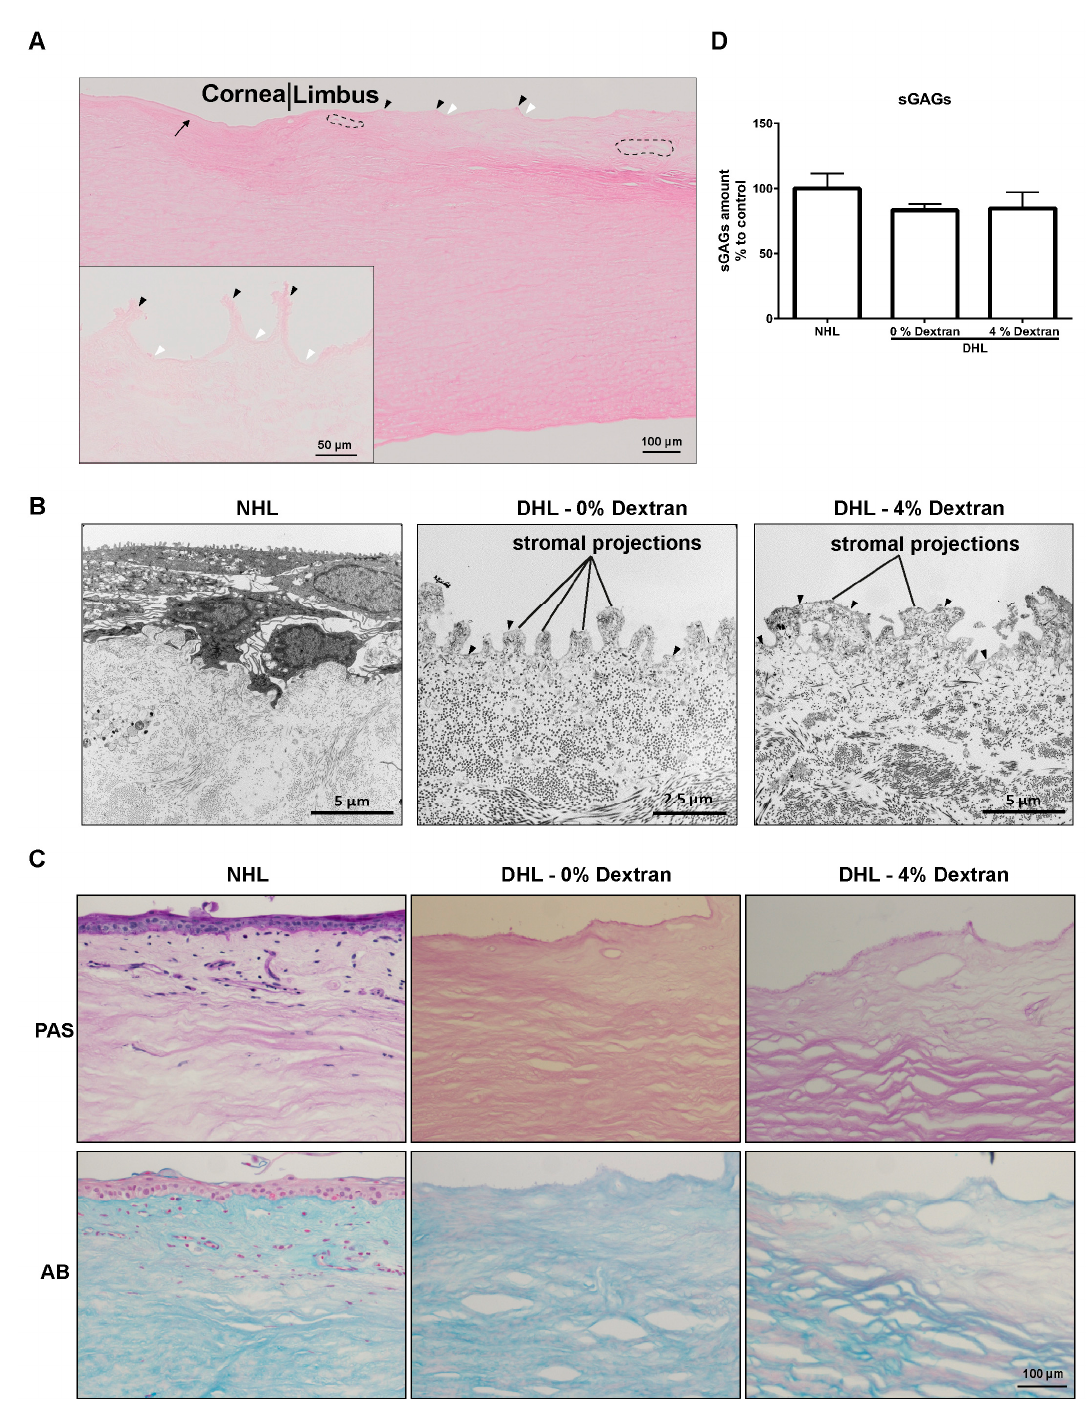
Figure 2. Structural and biochemical composition of the decellularized human limbus (DHL). ( A ) The hematoxylin and eosin staining of DHL scaffold showing the Bowman’s layer (arrow), connective tissue protrusions (black arrowheads), invaginations (white arrowheads), and vascular gaps (dashed circles). Insight showing the stromal projections (black arrowheads) and invaginations (white arrowheads). ( B ) The transmission electron microscopy (TEM) micrographs of the NHL and DHL in 0 or 4% dextran; the anterior surface of limbus showing cells on the NHL but no cells on the DHL; DHL scaffolds showing the stromal projections and the regular arrangement of collagen fibrils similar to NHL. ( C ) Histological evaluation of extracellular matrix content by periodic acid Schiff (PAS) and alcian blue (AB) on DHL (with 0 or 4% dextran) compared with NHL. ( D ) Sulfated glycosaminoglycan (sGAG) content of DHL in 0 or 4% dextran in comparison to NHL. The graph represents a percentage (%) of sGAG content in limbal scaffolds and data are expressed as means ± S.E.M. ( n =